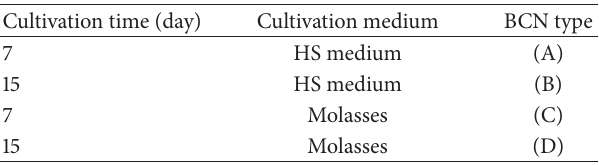
Table 1: Different BCN types as biomatrices used for urease